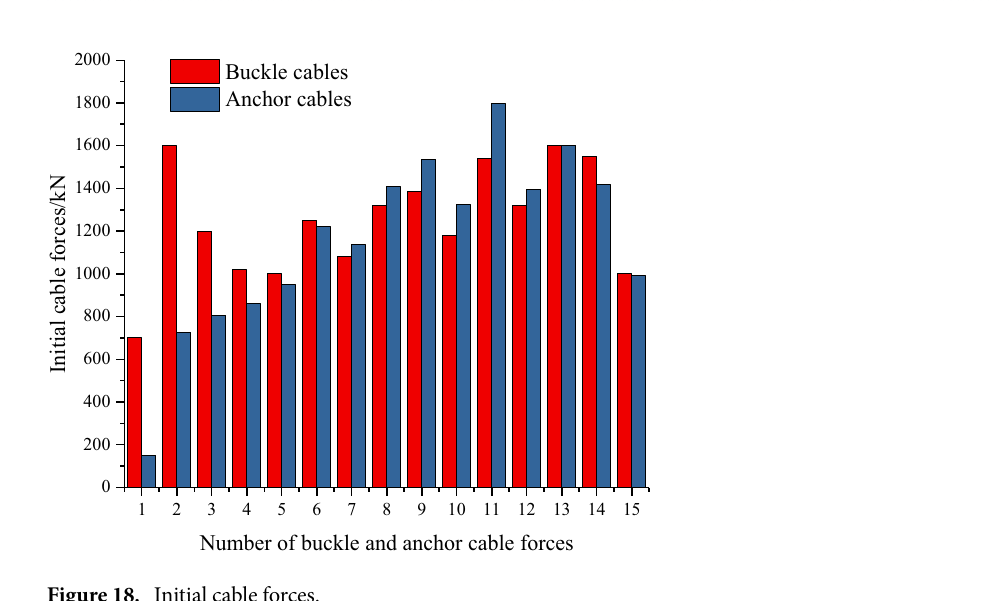
Figure 18. Initial cable